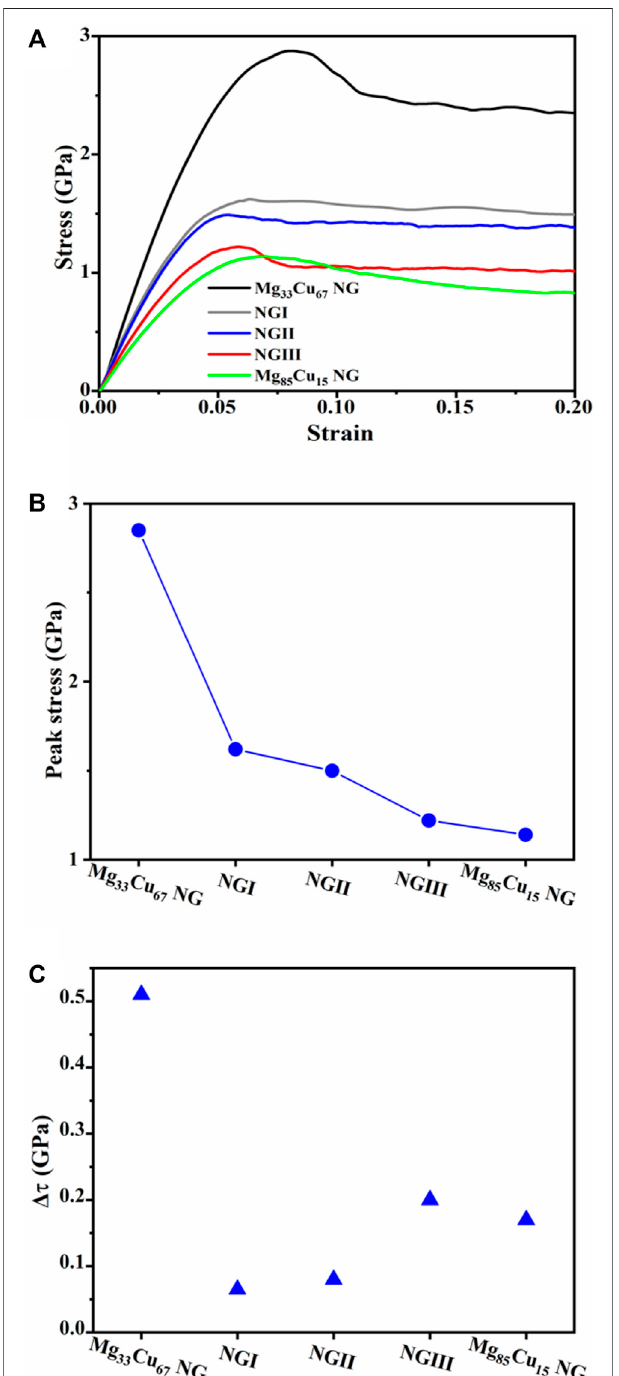
FIGURE5 | (A) Engineering tensile stress-strain curves, (B) peak stress, and (C) Δ τ for NGI, NGII, NGIII, together with single-phase NGs for comparison.